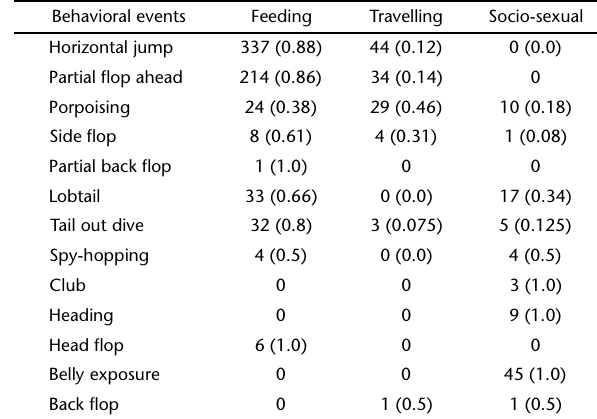
Table II. Frequency of behavioral events in the different behavioral states of Sotalia guianensis at Ilha Grande Bay, Brazil. In parenthesis, there is the proportion of each event in relation to the total occurrences.